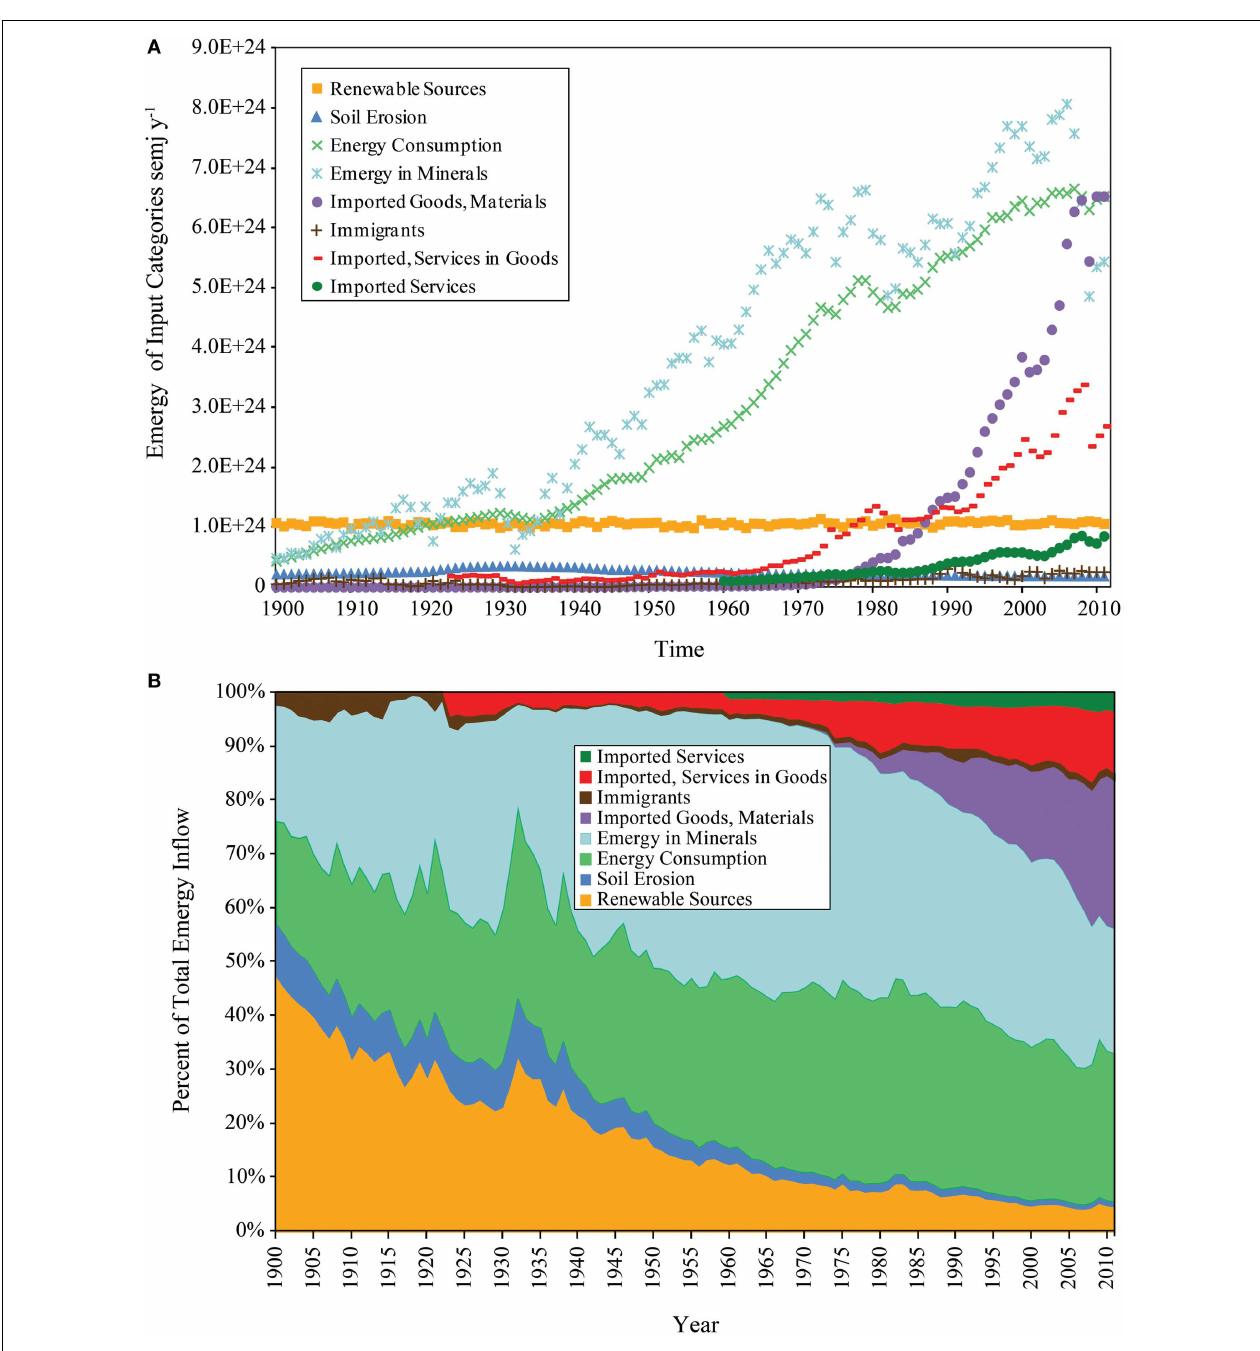
FIGURE 4 |Temporal patterns of emergy inflows to the U.S. economy and of annual emergy use (empower) from 1900 to 2011 are shown . (A) Temporal pattern of the major classes of emergy inflows; (B) structure of the major emergy inflows to the U.S. given as percent composition of the total.